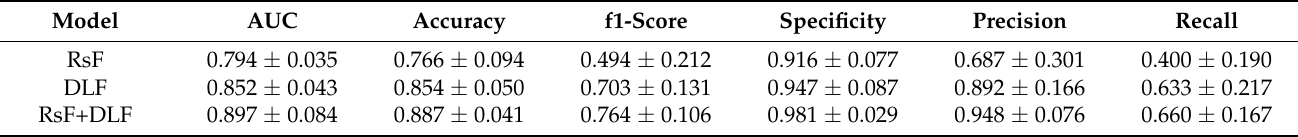
Table 5. The performance of radiomics-based model, deep learning-based model and integrated model on 5-Fold cross